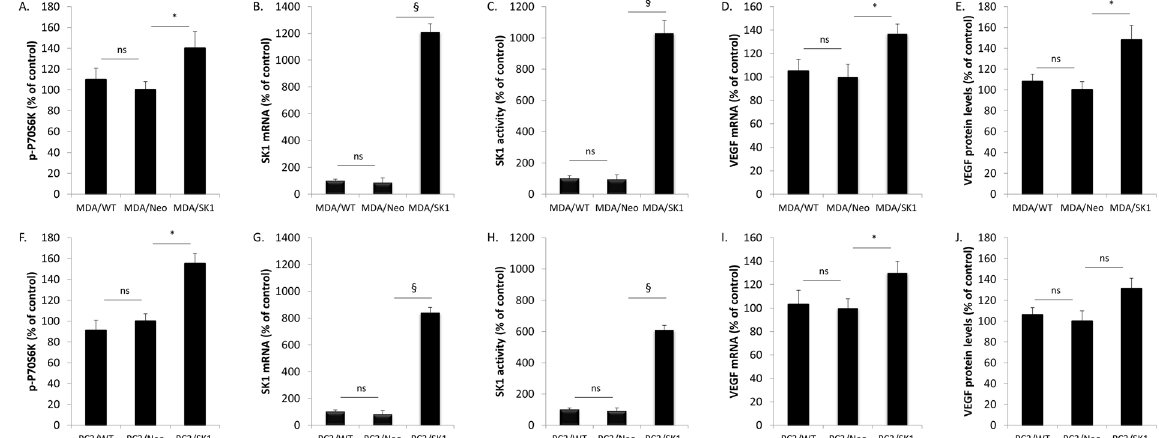
Figure 4. Overexpression of SK1 increases basal P70S6K phosphorylation and VEGF expression. Cell extracts for wild type MDA-MB-231 (MDA/WT) and PC3 (PC3/WT), empty vector-transfected MDA-MB-231 (MDA/Neo) and PC3 cells (PC3/Neo) and MDA-MB-231 and PC3 cells stably transfected with human SK1 (MDA/SK1 and PC3/SK1, respectively) were collected. ( A,F ) P70S6K phosphorylation was measured using ELISA. ( B,G ) SK1 expression and VEGF expression ( D,I ) was determined by qRT-PCR. ( C,H ) SK1 activity was measured using radiolabelling. ( E,J ) VEGF protein levels were measured using ELISA. Columns, mean of three independent experiments performed in triplicate; bars, SEM. ( * P < 0.05; ** P < 0.01; § P < 0.001; ns, not significant, P > 0.05).